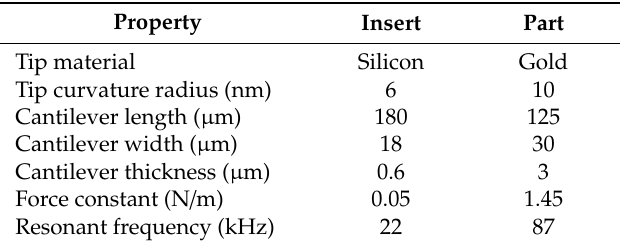
Table 2. AFM measuring setup for the topography of the plastic